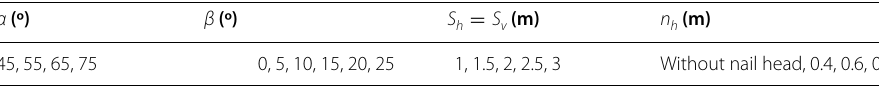
Table 4 The variation range of soil nail